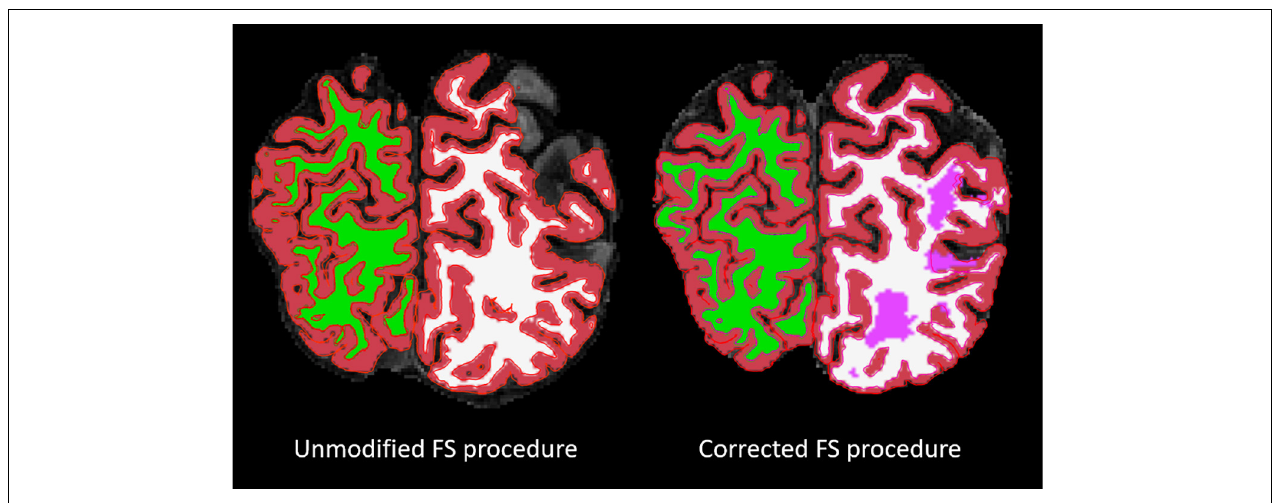
FIGURE 2 | Overlaid on a skull-stripped T1, the left image shows the segmentation result from the FS unmodified procedure and the right image shows the segmentation result from the FS corrected procedure. The segmentation colors are as follows: red = GM; green/white = right/left WM; pink = lesion. TABLE 3 | Cortical thickness analyses showing significant clusters with Montreal Cognitive Assessment scores corrected for multiple comparisons. Anatomical Region Max Surface area of Total MoCA score Left Superior Parietal Left